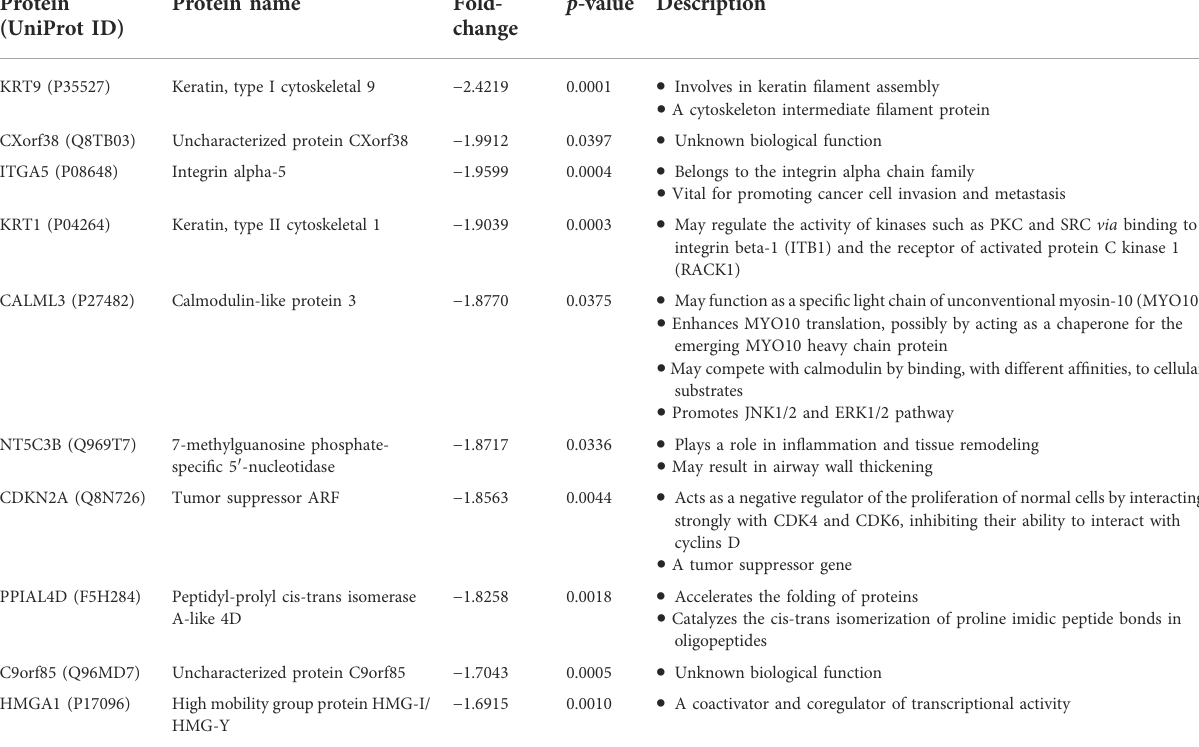
TABLE 2 Top-10 downregulated proteins identi fi ed in the ZIP8-KO cells. Protein (UniProt